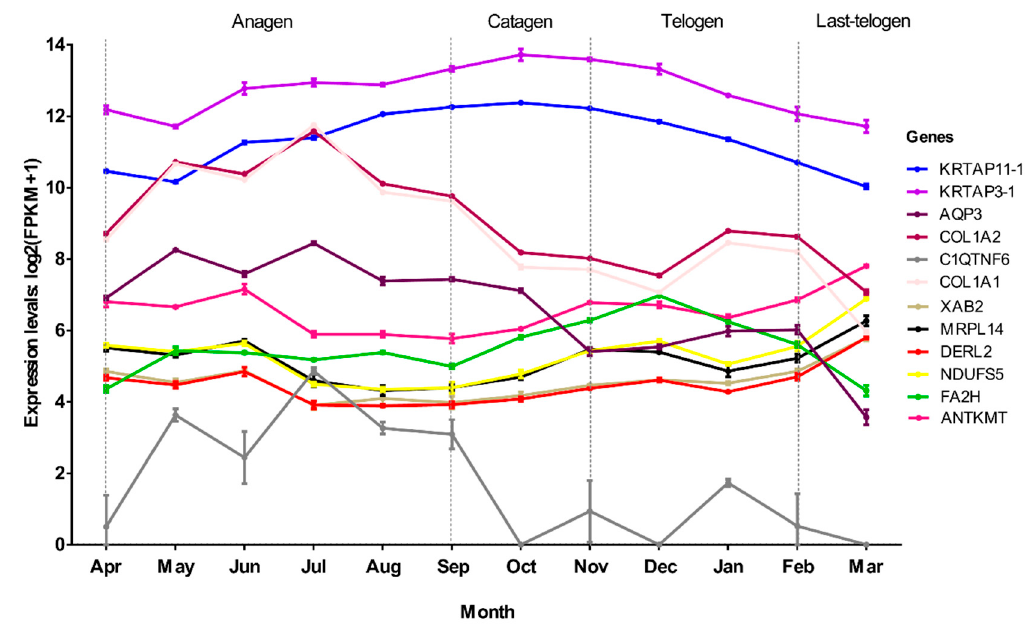
Figure 7. Line chart of the expression changes of 12 hub genes throughout the hair follicle cycle of cashmere goats.